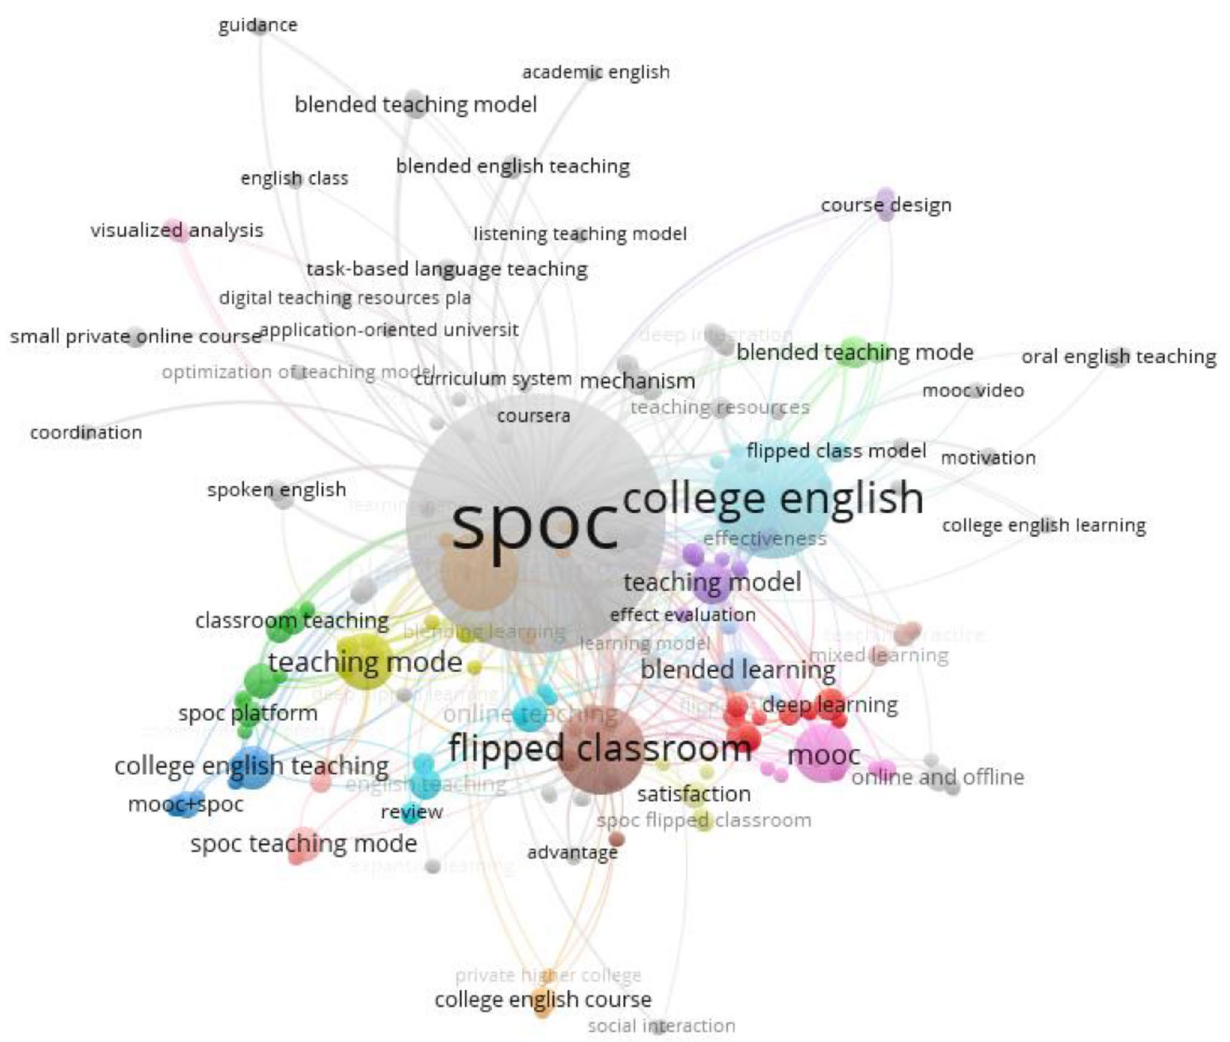
Fig. 1 The network relationship diagram of the literature in the